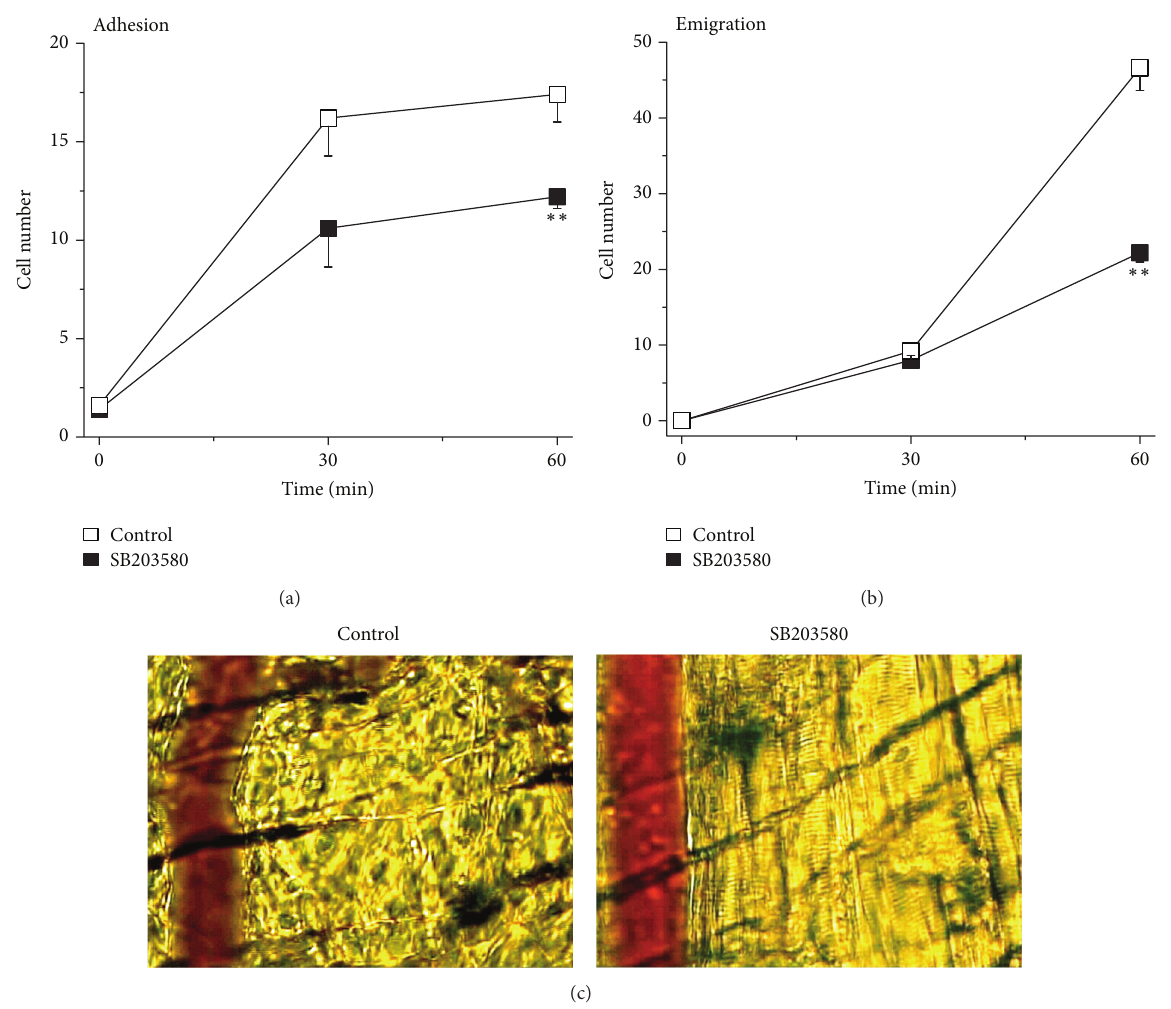
Figure 2: Effect of SB203580 on KC-induced neutrophil adhesion and emigration. (a) Time course of the number of adherent neutrophils (cells/100 𝜇 m venule) triggered by KC in the absence (control, white) and in the presence (black) of p38 MAPK inhibitor SB203580 (100nM) 30 min prior to and 60min following the placement of KC-containing gel. Data are means ± SEM ( 𝑛 = 5 ). ∗∗ indicates significant difference ( 𝑃 < 0.01 ) from the control without SB203580 ( t -test). (b) Time course of the number of emigrated neutrophils (cells/235 × 208 𝜇 m 2 field) triggered by KC in the absence (control, white) and in the presence (black) of p38 MAPK inhibitor SB203580 (100nM) 30 min prior to and 60min following the placement of KC-containing gel. Data are means ± SEM ( 𝑛 = 5 ). ∗∗ indicates significant difference ( 𝑃 < 0.01 ) from the control without SB203580 ( t -test). (c) Representative images from intravital video microscopy showing a postcapillary venule and the surrounding cremasteric tissue with adherent and emigrated neutrophils triggered by KC for 60 min and in the absence (left panel, control) and in the presence of SB203580 (right panel,